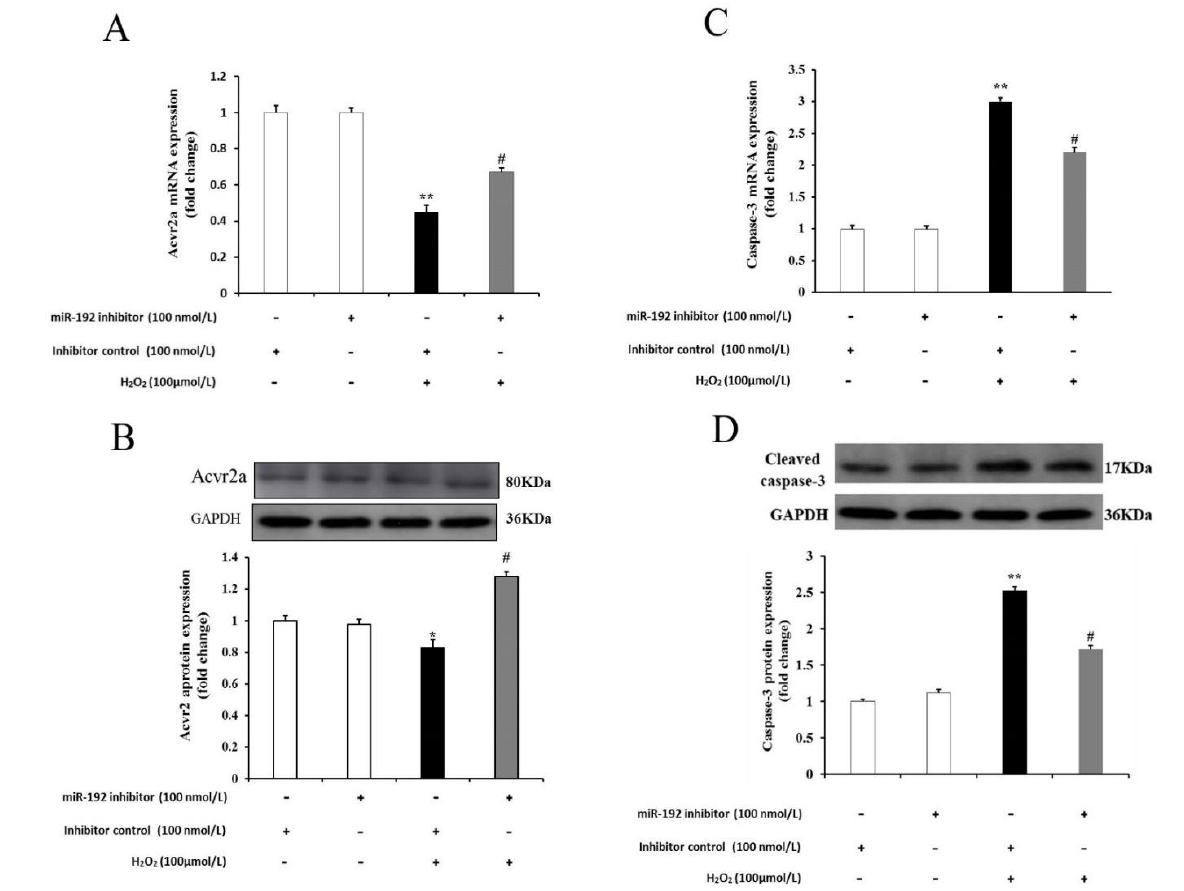
Figure 10. Downregulation of miR-192 attenuates H 2 O 2 -induced oxidative injury in PGCs through the regulation of Acvr2a and caspase-3. ( A ) Effects of miR-192 downregulation on the mRNA expression of Acvr2a. ( B ) Effects of miR-192 downregulation on the protein expression of ACVR2A. ( C ) Effects of miR-192 downregulation on the mRNA expression of caspase-3. ( D ) Effects of miR-192 downregulation on the protein levels of cleaved caspase-3. Data are shown as mean ± SE. ( n = 3). * p < 0.05, ** p < 0.01 vs. the H 2 O 2 -free group (control); # p < 0.05 vs. the H 2 O 2 plus inhibitor